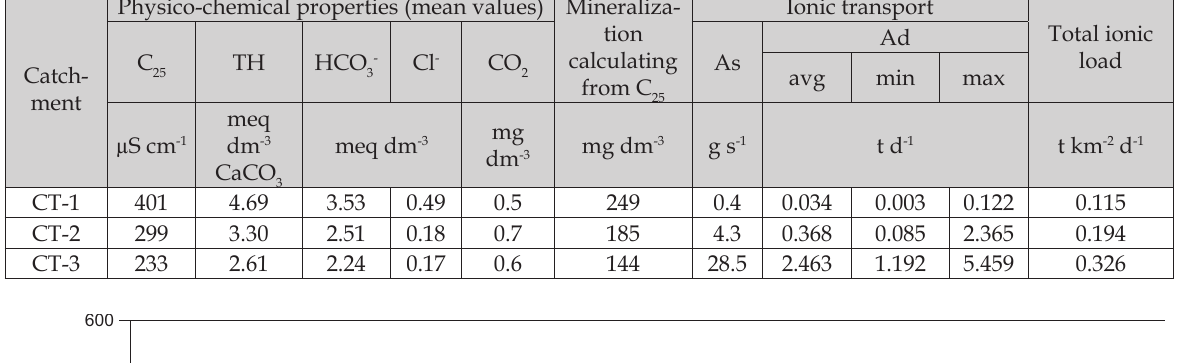
Table 3. Physical and chemical properties of water draining the investigated river catchments in the area